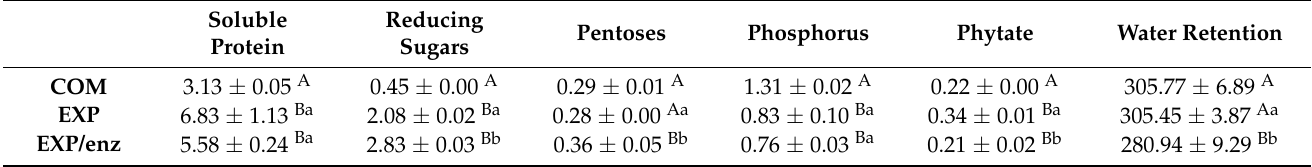
Table 2. Differences in the nutrient content and water retention of experimental feeds (g/100 d.m.). Soluble